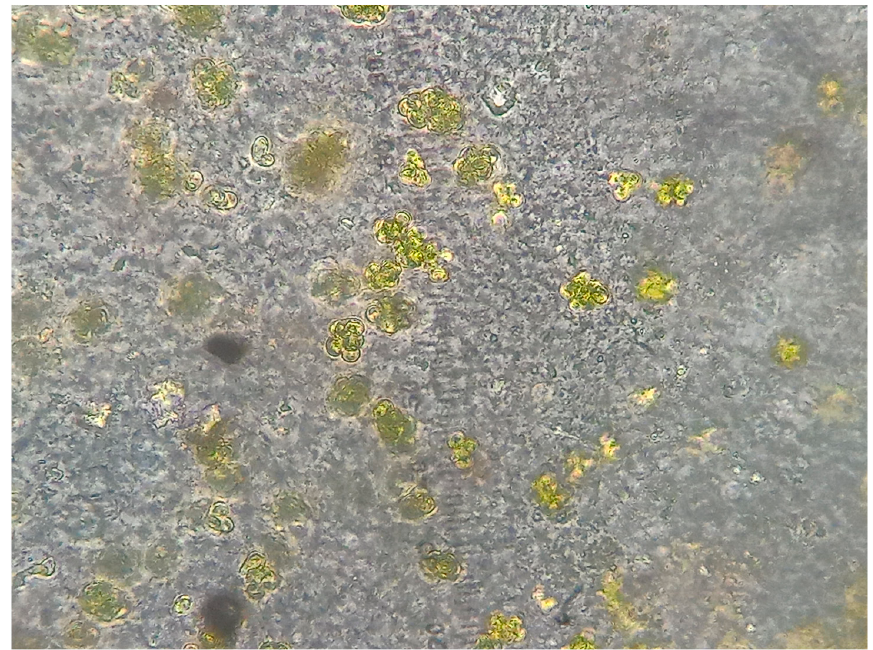
Figure 7. High concentration of Ochrosphaera neapolitana cell groups in the original samples taken from Kalamis, Istanbul, on 11 June 2021; the scale is 50 µm.